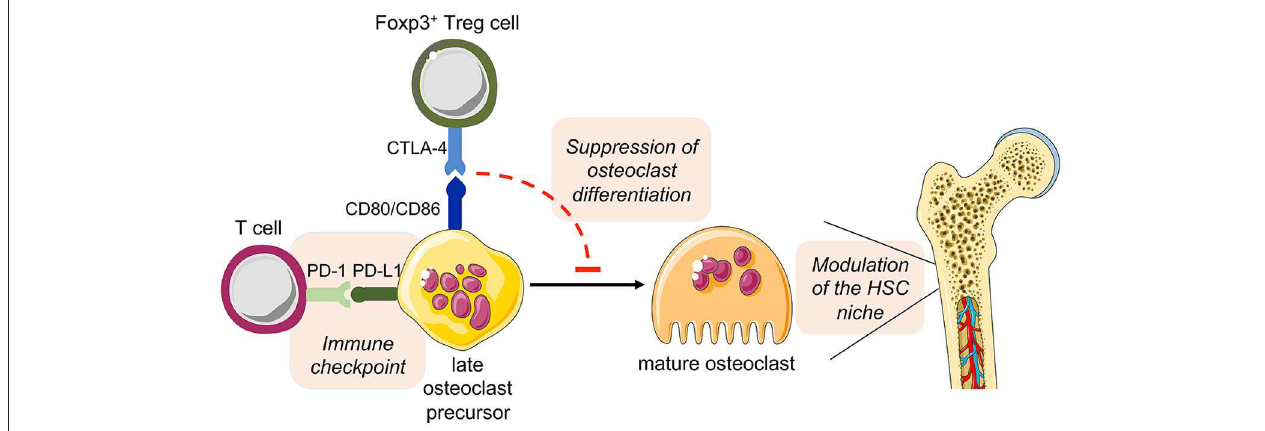
FIGURE 5 | Hypothesized direct cross-talk between osteoclast precursors and T cells and the indirect effect on hematopoiesis. The expression of the costimulatory molecules CD80 and CD86 on osteoclast precursors has been implicated in the interplay with Foxp3 + Treg cells (via the inhibitory molecule CTLA-4), leading to the suppression of the differentiation of osteoclast precursors into mature functional osteoclasts. As a consequence, disturbed bone remodeling results in modulation of the HSC niche. On the other hand, osteoclast precursors are able to upregulate the expression of PD-L1, whose interaction with PD-1 on T cells has immune modulatory functions, thus representing a crucial immune checkpoint. This figure was in part created with modified Servier Medical Art templates, licensed under a Creative Commons Attribution 3.0 Unported license: